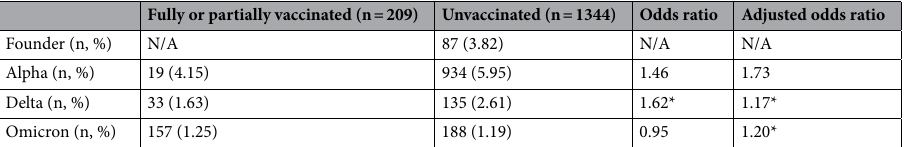
Table 11. Comparison of mortality rate and mortality odds ratio by variants between fully or partially individuals and unvaccinated individuals. p -value < 0.05 is significant, *denotes p -value < 0.05.